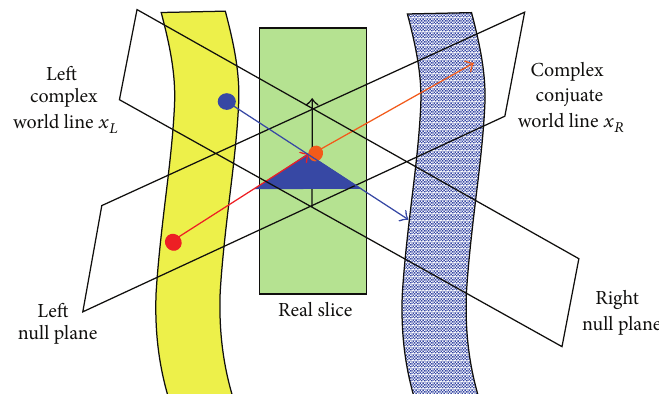
Figure 2: The complex conjugate left and right null planes generate the left and right retarded and advanced roots.